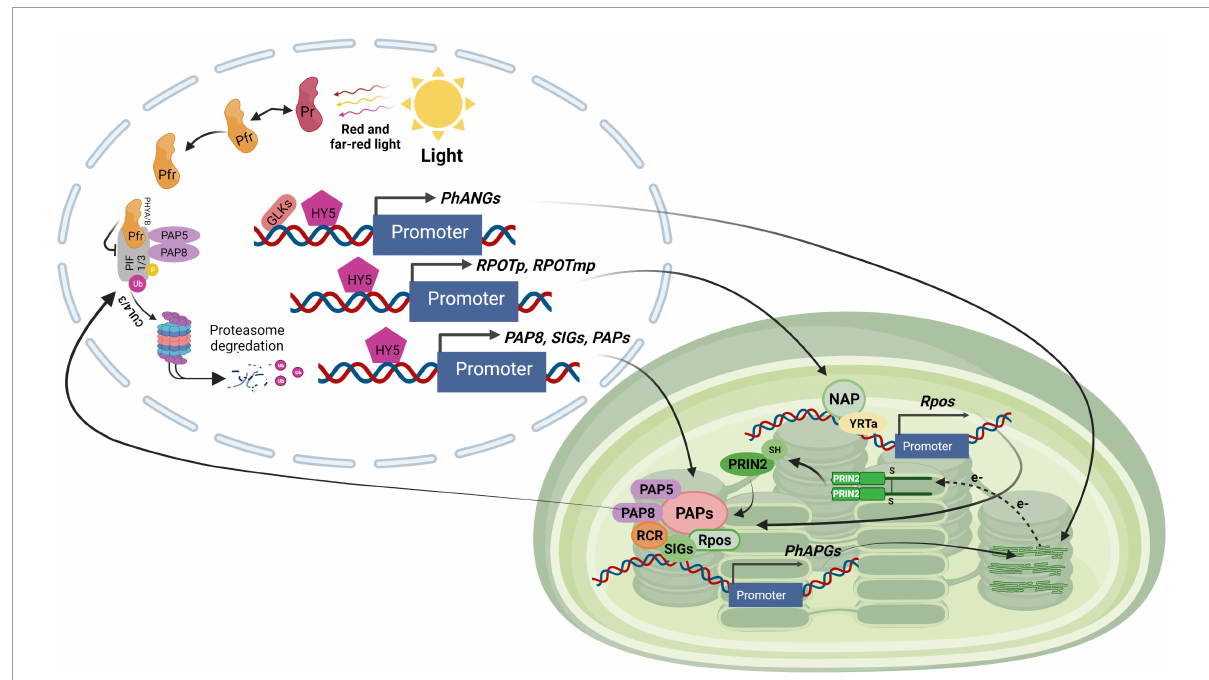
FIGURE3 Light signaling pathway controlling plastid transcription. GLKs, HY5 and unknown regulators stimulate the expression of chloroplast proteins encoded by nuclear genes such as PhANGs, RPOTp, and RPOTmp (encoding NEP), SIGs and PAPs (encoding PEP components) in response to light exposure. NEP transcribes the rpo genes of the PEP core proteins. The PEP core is associated with PAPs, which include PAP5 and PAP8, two dual-localized components implicated in PHY-mediated PIF1 and PIF3 degradation in the nucleus. PEP activity is regulated by other proteins such as PRIN2 in a redox-dependent way. The PEP complex transcribes the photosynthesis-associated plastid-encoded genes ( PhAPGs ). Their products aid in the establishment of photosynthesis when combined with the proteins encoded by